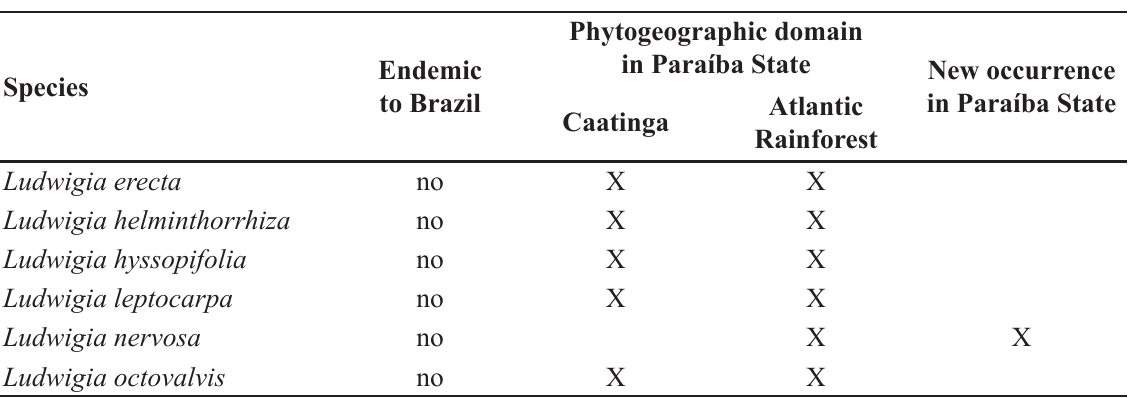
Table 1. Species of Ludwigia L. (Onagraceae) in the Paraíba State,